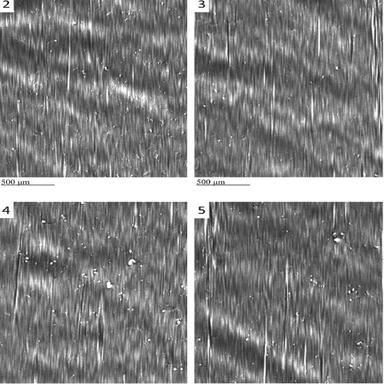
High magnification x-ray grazing incidence topograph from boxes in Fig. 4 showing threading dislocation contrasts as bright or dark dot shapes of various dimensions. The threading dislocation density was measured to be (1) 5.9 × 103 cm− 2 ; (2) 6.5 × 103 cm− 2 ; (3) 3.6 × 103 cm− 2 ; (4) 5.2 × 103 cm− 2 ; (5) 4.6 × 103 cm− 2 and the average is 5.16 × 103 cm− 2 .